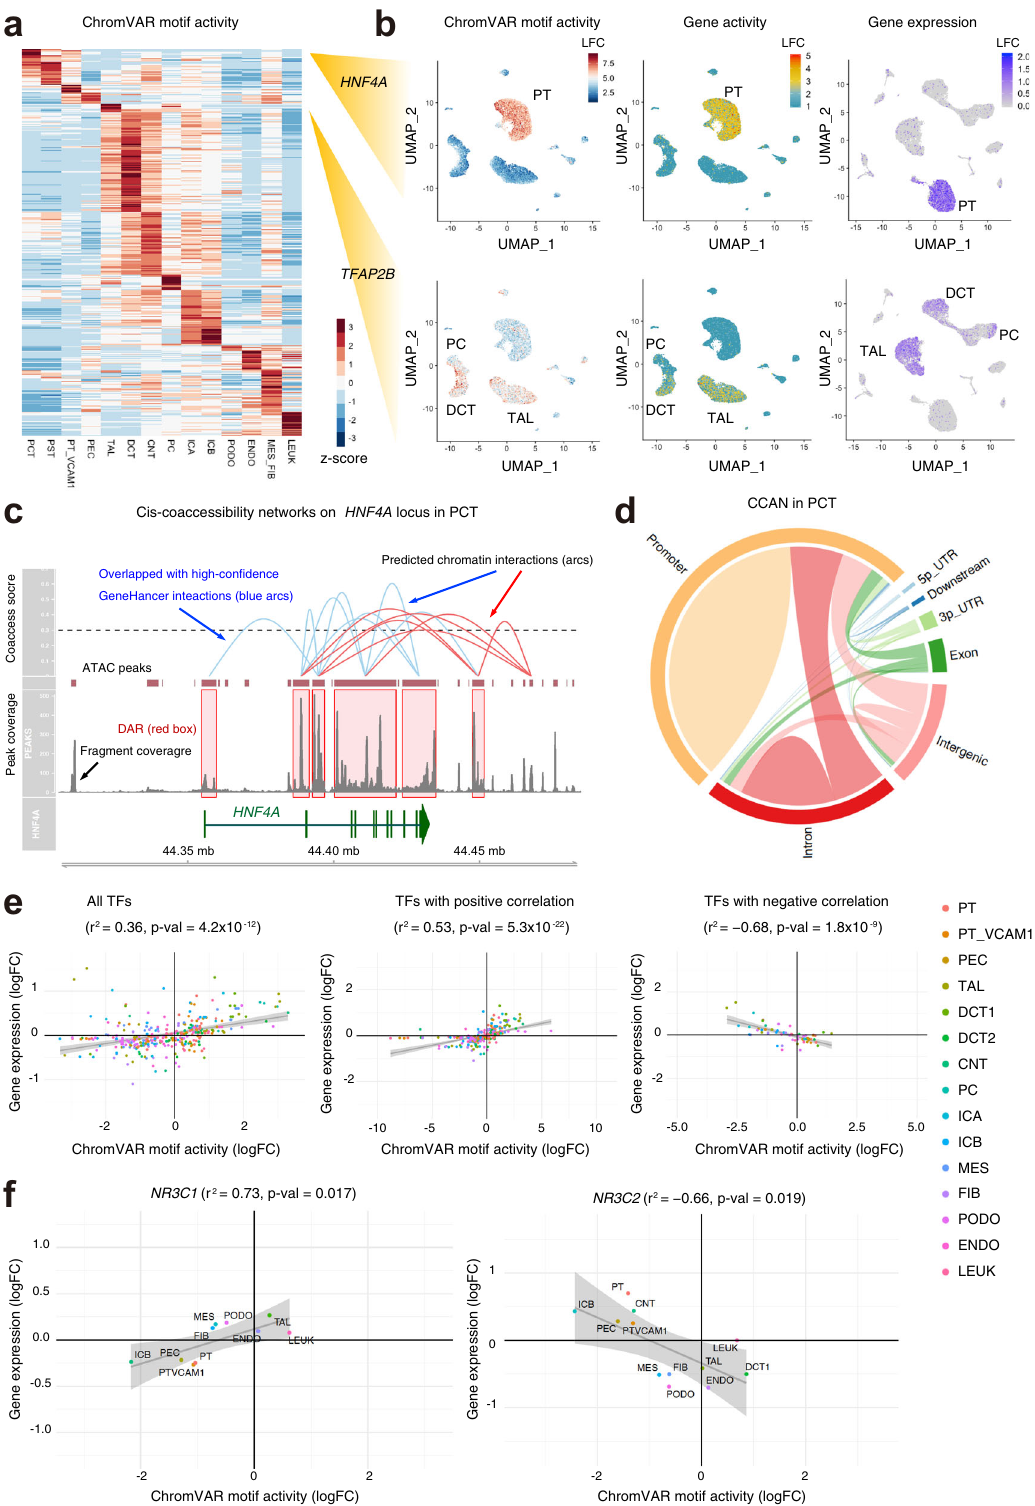
correlation ( n = 403). We hypothesize that transcription factors with positive correlation between motif activity and transcription factor expression may be acting as transcriptional activators within DAR and those with negative correlation are acting as transcriptional repressors. Surprisingly, glucocorticoid receptor ( NR3C1 ) showed a positive correlation between motif activity and